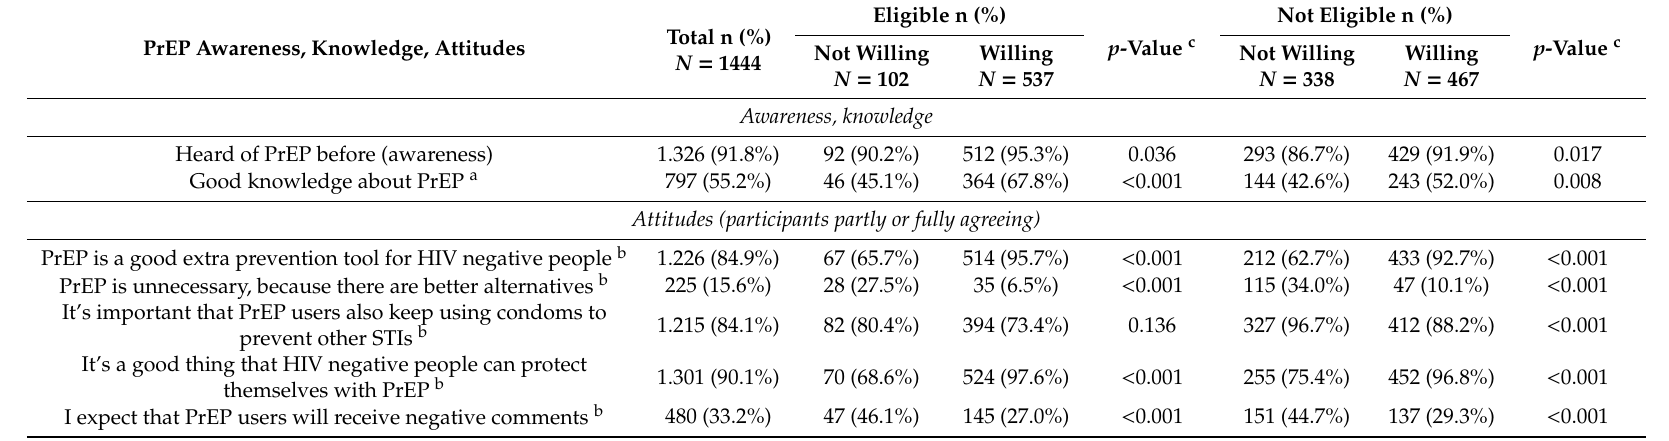
Table 5. Awareness, knowledge and